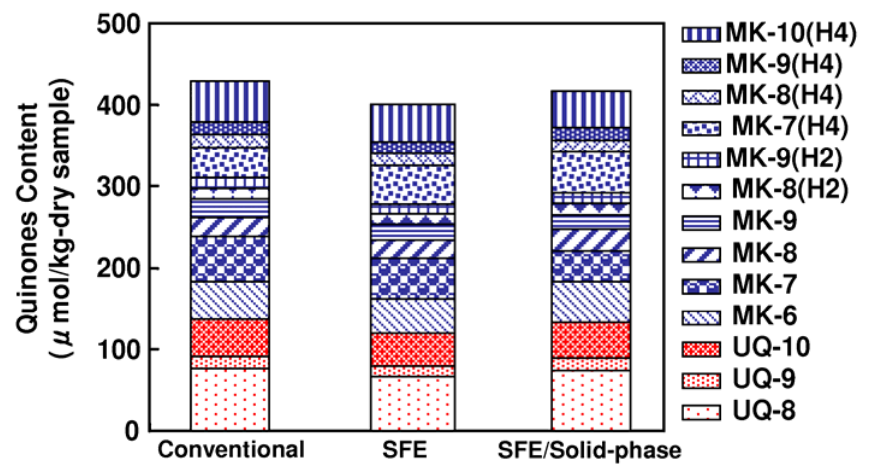
Figure 2. Effect of different treatments on the total content of the extracted quinones from activated sludge; conventional solvent extraction method (Conventional); SFE/UPLC off-line with Sep-Pak cartridge (SFE); SFE/UPLC in-line with Sep-Pak cartridge (SFE/Solid-phase) (n =